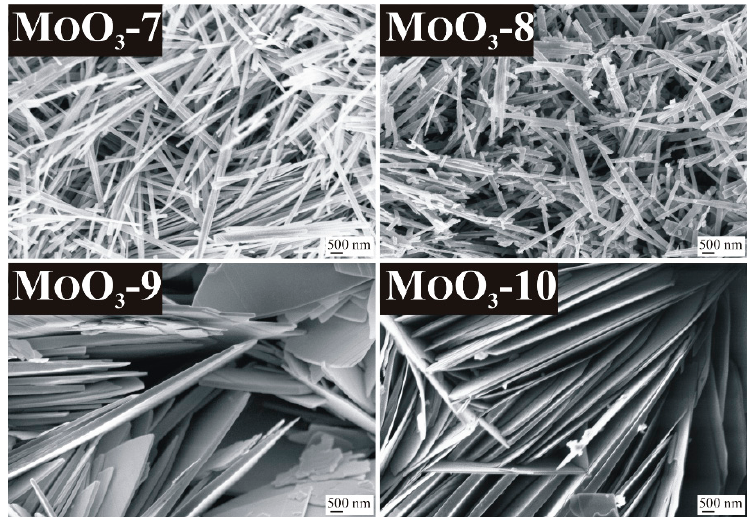
Figure 4. SEM images of the samples synthetized in the hydrothermal reaction of AHM and HNO 3 with various additives, MoO 3 -7: CTAB, 240 °C, 3 h, MoO 3 -8: CTAB, 240 °C, 6 h, MoO 3 -9: CrCl 3 , 240 °C, 3 h, MoO 3 -10: CrCl 3 , 240 °C, 6.